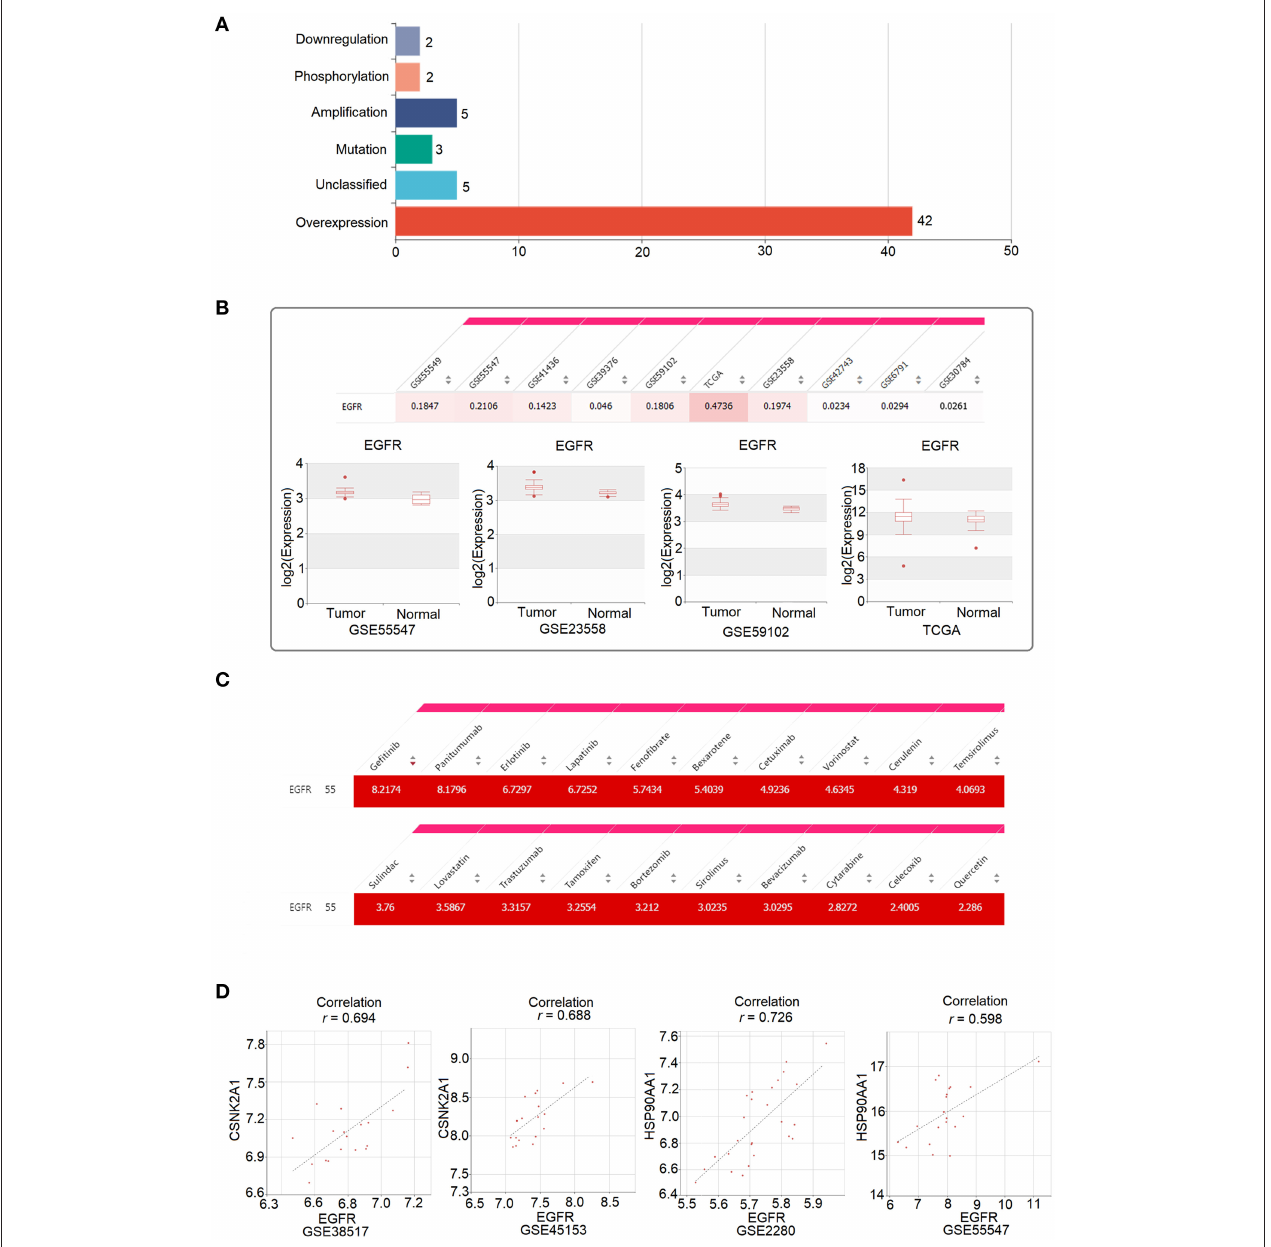
FIGURE 5 | Oncogenic role of EGFR in head and neck cancer and its clinical implication, as revealed by HNCDB. (A) The PubMed abstracts indicating a relationship between EGFR and HNC. (B) Significant upregulation of EGFR in tumor samples compared to in normal samples in the HNC gene expression datasets collected in HNCDB. (C) The connectivity score for the identified drugs and EGFR. (D) Correlation between EGFR and the two targets of quercetin (CSNK2A1 and HSP90AA1).